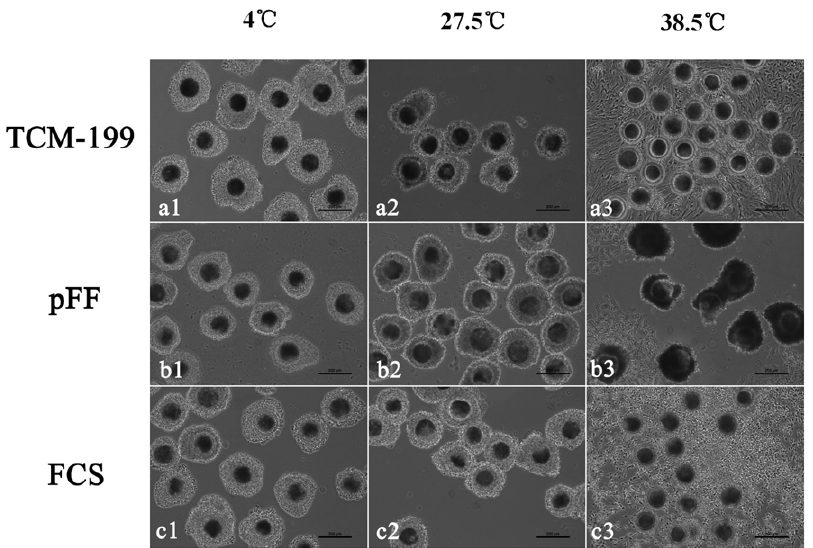
Figure 1. Morphologic changes of porcine cumulus-oocyte complexes (COCs) after preservation for 3 d. a1, a2, b1, b2, c1, c2, When preserved in TCM-199, pFF and FCS at 4 u C or 27.5 u C, cumulus cells attached tightly to oocytes and displayed no expansion; a3, c3, After preservation in TCM-199 and FCS at 38.5 u C, almost all of the cumulus have shed from the oocytes; b3, After pFF preservation at 38.5 u C, the whole COCs degenerated and showed black appearance; b2, c2, After preservation in pFF and FCS at 27.5 u C, oocytes displayed dark ooplasm with compact cumulus cells. Scale bar =200 m m.